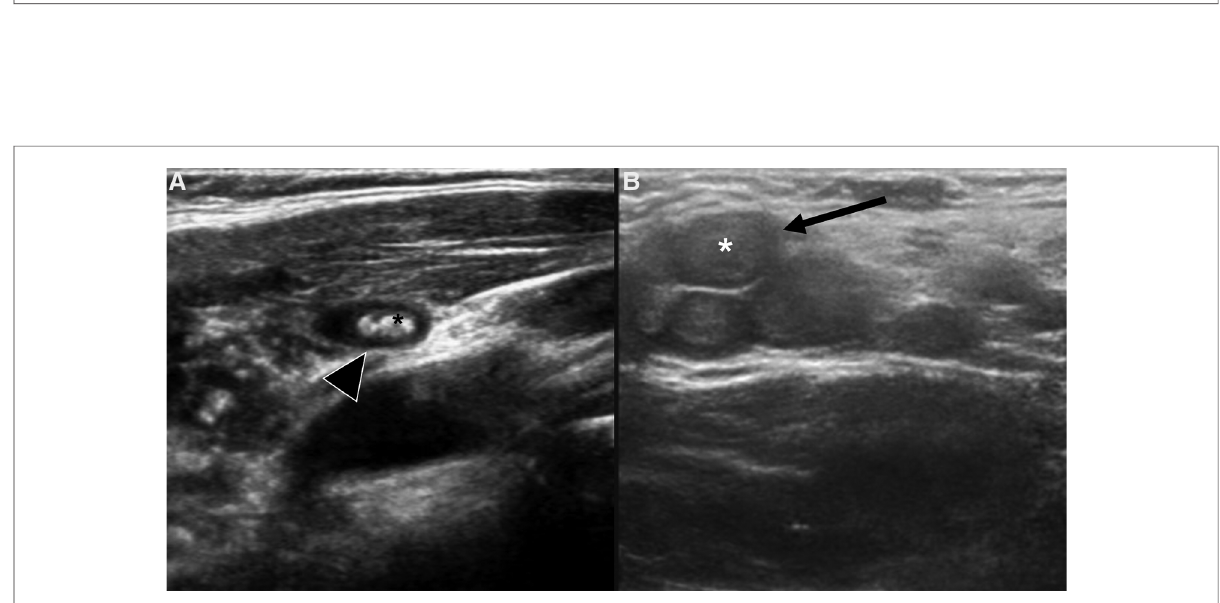
FIGURE 14 Different forms of target sign on US. ( A ) Phlebolith within a venous malformation, appearing as a hyperechoic structure (black asterisk) surrounded by an anechoic formation which represents the dilated venous channel (black arrowhead). ( B ) Plexiform neuro fi bromas appear as non-compressible, polylobate lesion made up of multiple con fl uent tubular masses (black arrow), consisting of a slightly hyperechoic core (asterisk) surrounded by a hypo/anechoic halo (black